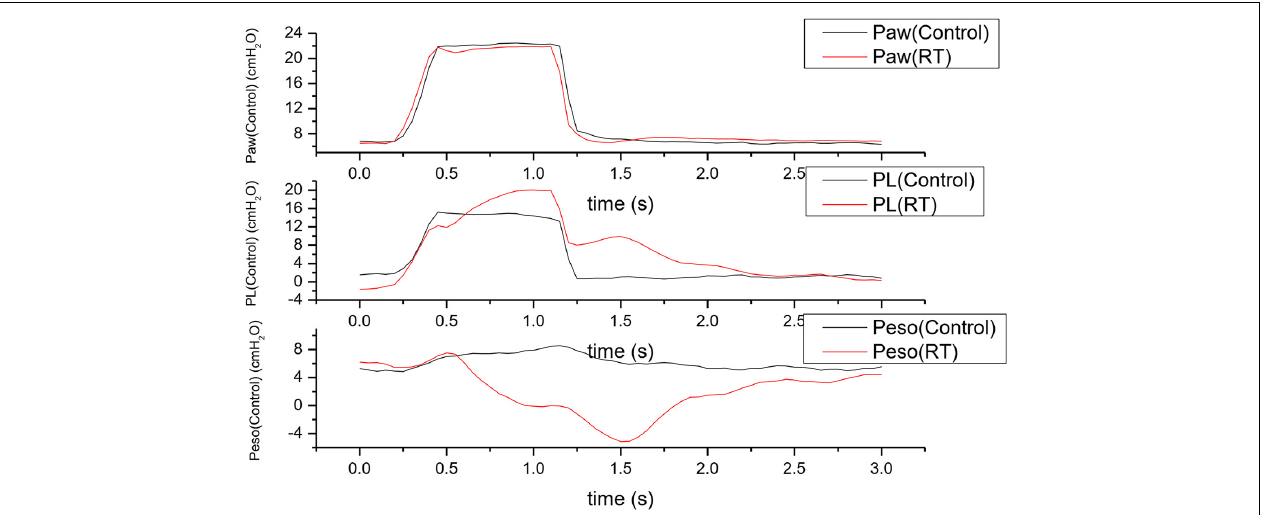
FIGURE 5 | An overlaping display of pressure waveforms of a control breath with reverse trigger and a control breath. Traces were acquired in patient No.4; Paw, airway pressure; PL, transpulmonary pressure; Peso, esophageal pressure. The black solid lines indicates the Paw, PL and Peso fluctuations during a mandatory or control breath. The red solid lines indicates the Paw, PL and Peso fluctuations during a breath with reverse trigger in the same patient. Comparing to the control breath, arising of patient effort or delta Peso may elevates PL during breath with reverse